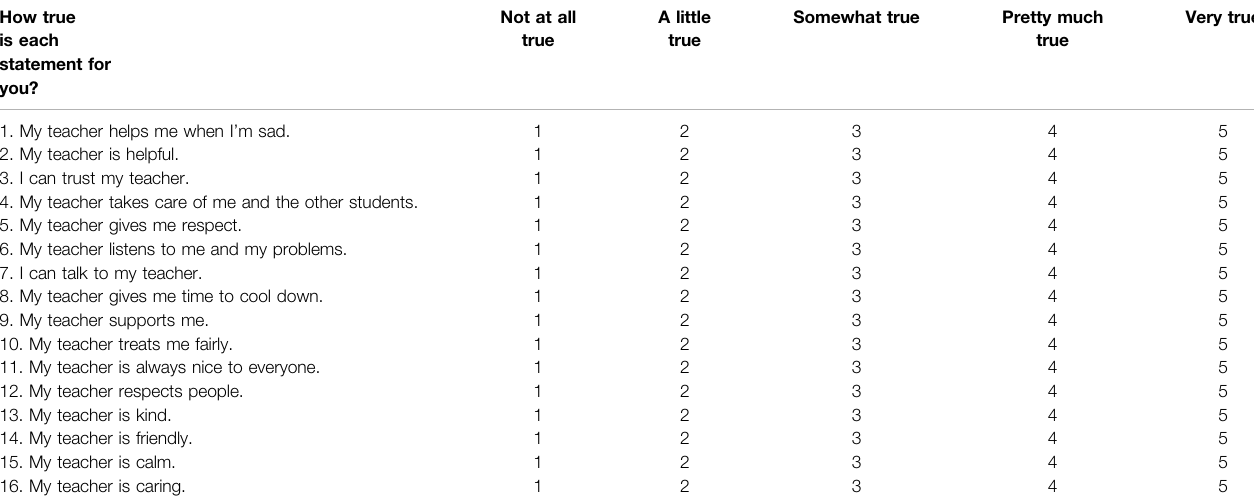
TABLE 1 | Caring student-teacher relationship scale (CSTR). How true is each